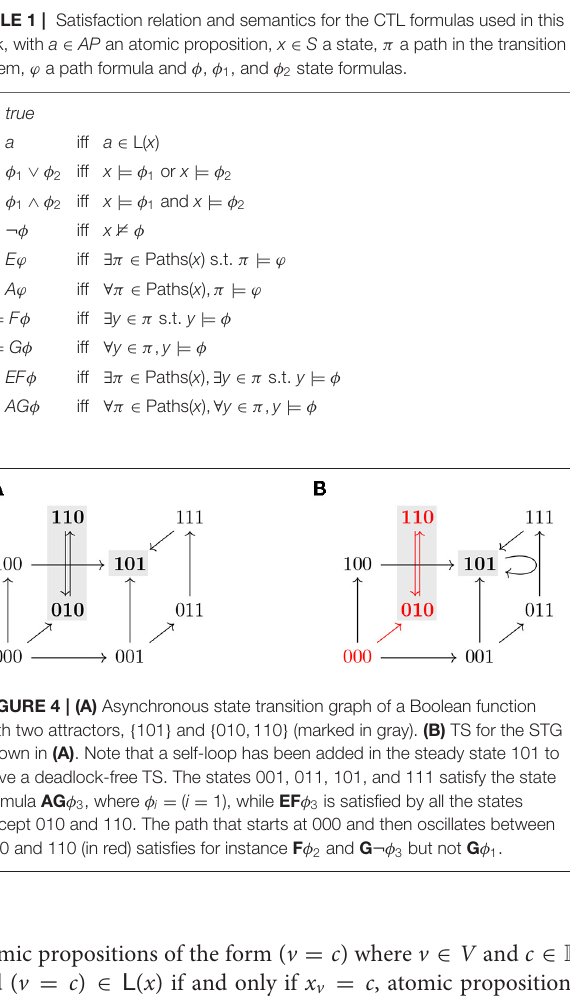
FIGURE 3 | The asynchronous dynamics of a Boolean function f and its restriction f ↾ gray. (cid:127) is a control strategy for P = 00 ∗∗ in AD ( f ). (cid:127) is not a trap space in f and it does not percolate to the target P nor to any other trap space in f ↾ unique trap space in f ↾ and (cid:127) * P , (cid:127) would not be identified as control strategy by the completeness approach. (cid:127)